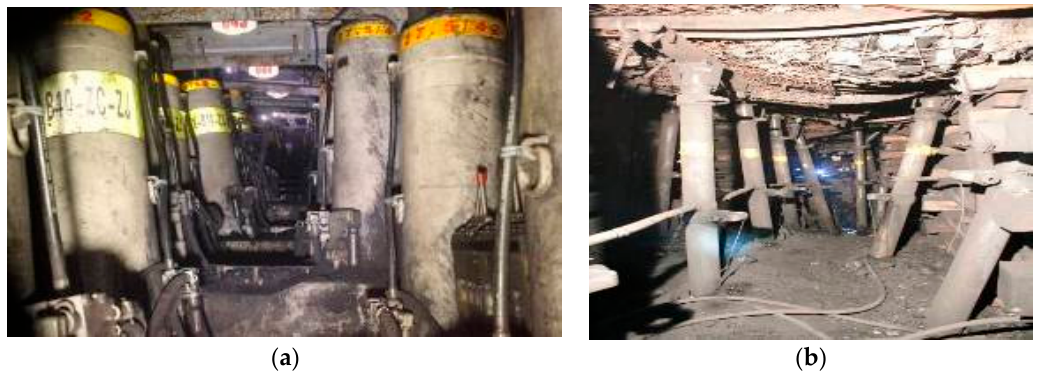
Figure 3. Strong strata behavior: ( a ) Crushed face supports; ( b ) Broken roadway pillars.